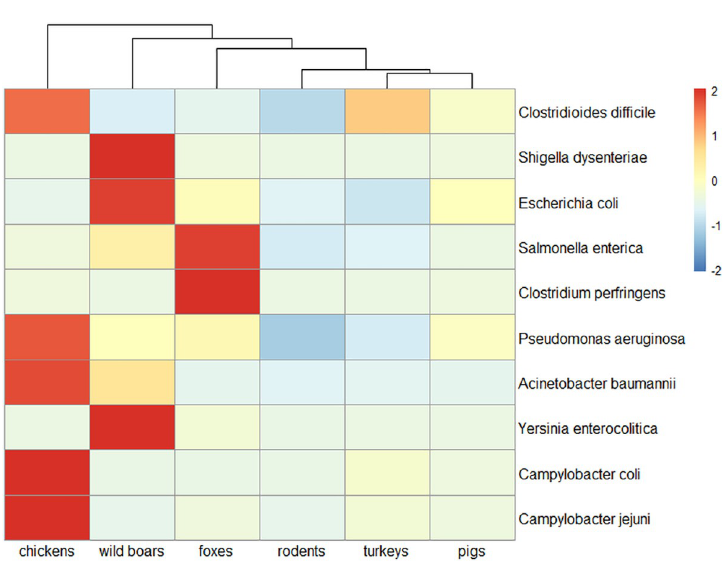
Fig 7. Pathogens occurrence by source animal. Heat map of selected bacterial pathogens based on relative abundances values with Z-score scaling. Samples with high relative abundances get positive values (red color) and those with relatively low get negative values (blue colors). Complete-linkage clustering of Euclidian distances was applied for clustering the samples.